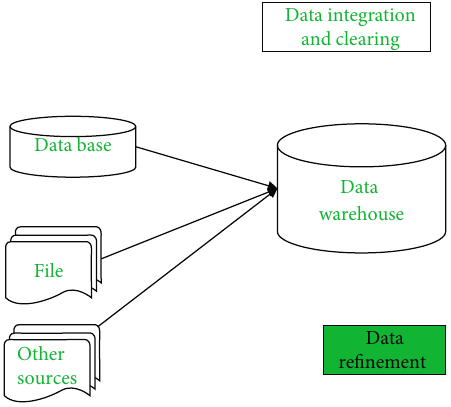
Figure 1: An example of the storage